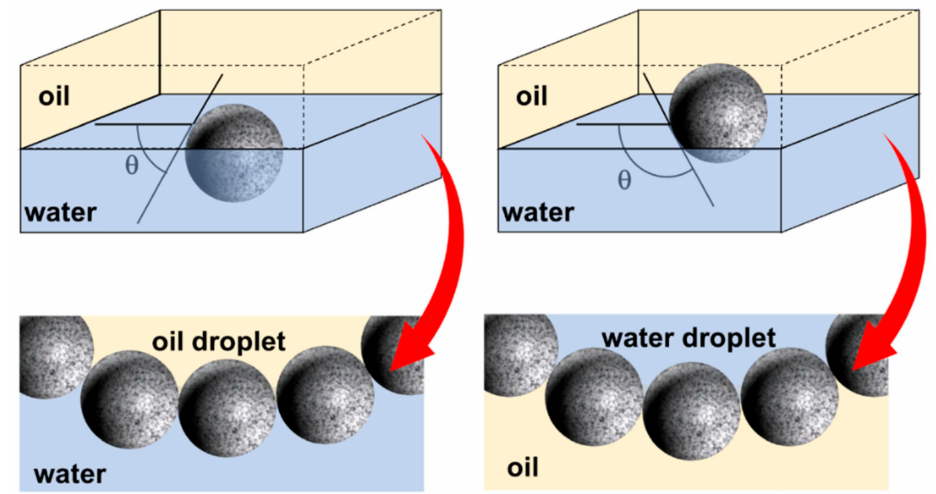
Figure 58. The three-phase contact angle, θ , and its relation to the type of Pickering